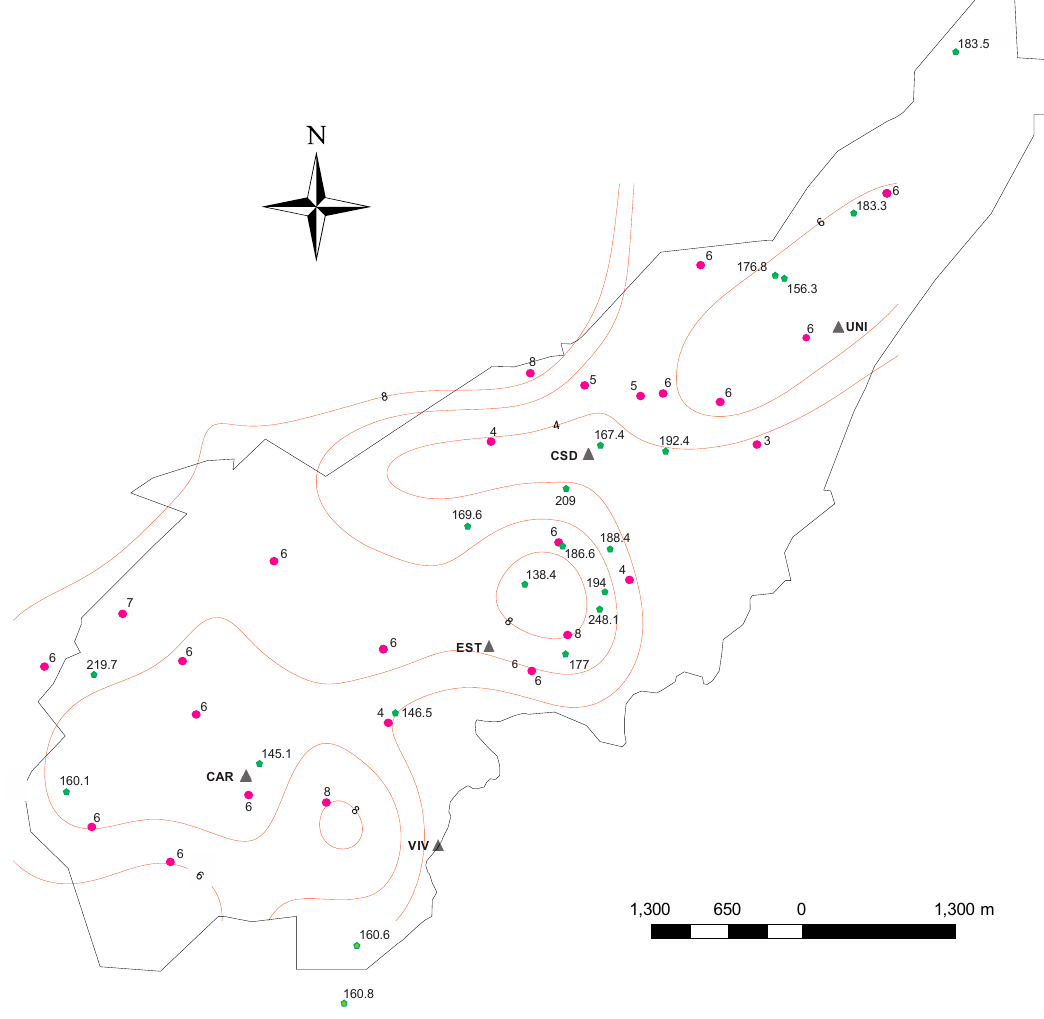
Figure 14. Spatial distribution of the horizontal amplification (red lines). The black line shows the city of Armenia. Red circles show locations of ambient noise measurements in 2002 together with their amplification value. Solid triangles show the stations that recorded aftershocks of the 1999 event. Green symbols mark seismic cone measurements, with their average shear wave velocity. Table 2. Shear wave velocity models at PE and HA determined from the SPAC method.